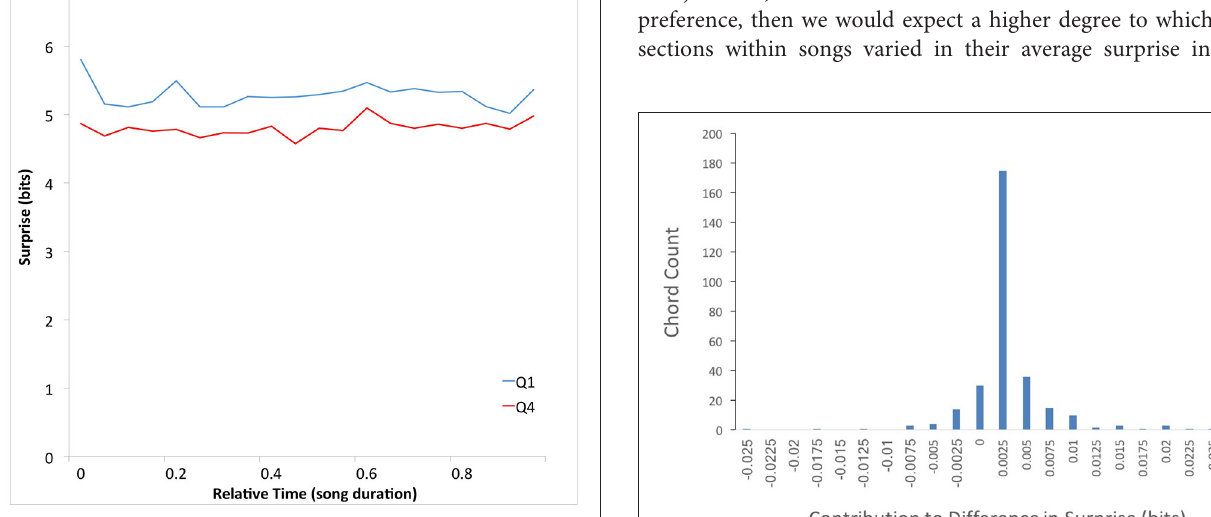
FIGURE 3 | Mean surprise as a function of time throughout the duration of songs for Q1 and Q4. The abscissas were normalized by the total duration of the songs. The mean surprise is higher in Q1 than in Q4 songs throughout their durations. Again, the superiority of Q1 songs is consistent with the Absolute-Surprise Hypothesis.